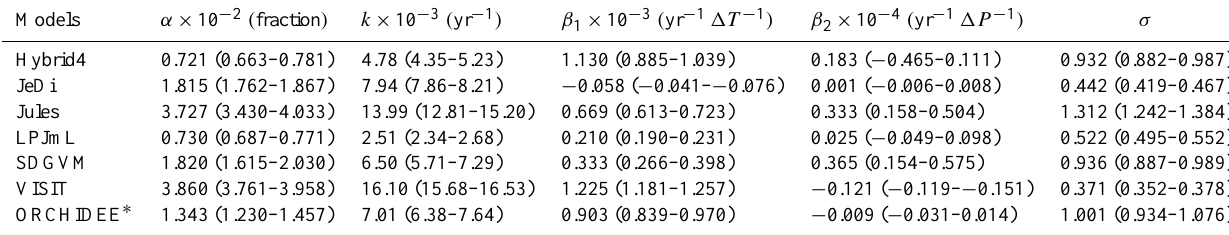
Table 2. Posteriors of statistical time-series analysis of each biome model.